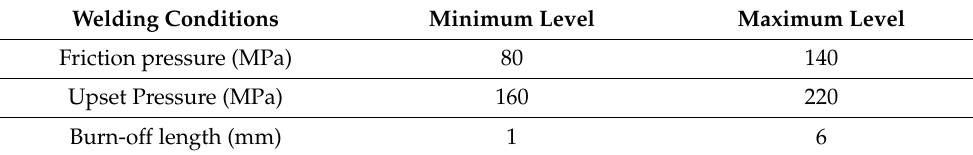
Table 1. The maximum and minimum level of evaluated factors (input parameters).